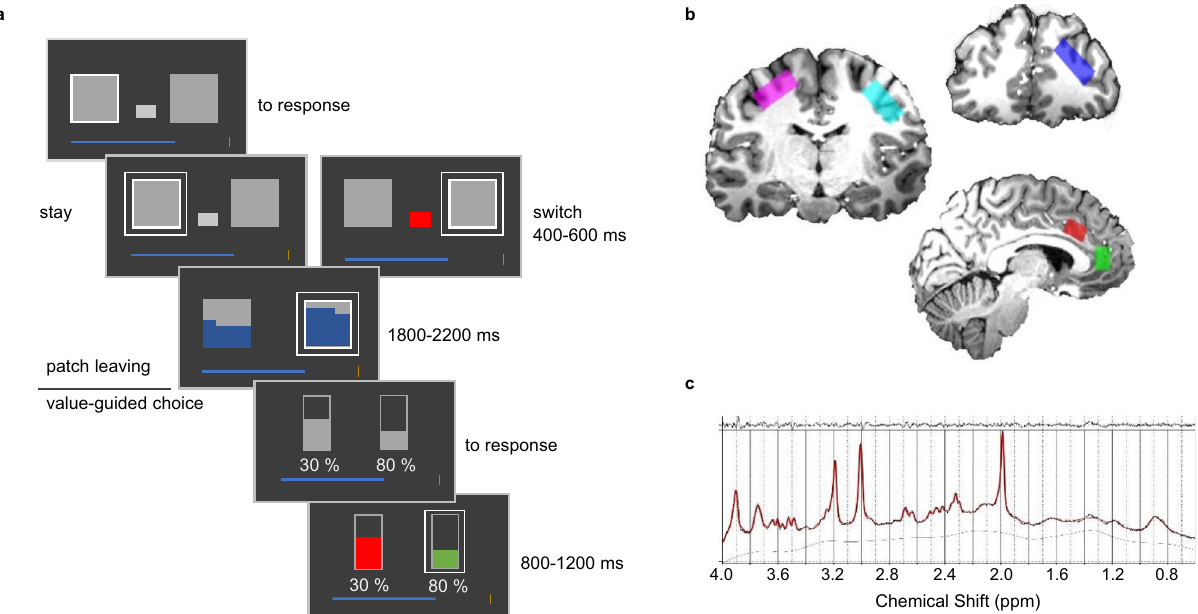
Fig. 1 Behavioural task and MRS recordings. a Schematic of the task structure. Participants made a patch decision in the fi rst stage of each trial. A white outline indicated the location of the participant ’ s current patch. If they chose to switch, they had to pay a cost indicated by the size of a grey rectangle. Following the choice, the values of both patches were revealed, indicated by the blue fi llings. In the value-guided choice phase, the chosen patch value was randomly divided between the two different options and reward probabilities were randomly assigned to them. Participants selected an option by pressing a button, which was followed by feedback on both options. If they obtained a reward, the blue progress bar at the bottom of the screen grew in proportion to this reward. b Example MRS voxel placement for one participant (Supplementary Fig. 3 for overlay of all participants). Spectroscopy voxels were placed in right dlPFC (blue), bilateral primary motor cortex (pink and cyan), dACC (red) and vmPFC (green). c Spectrum obtained from dACC of one exemplary